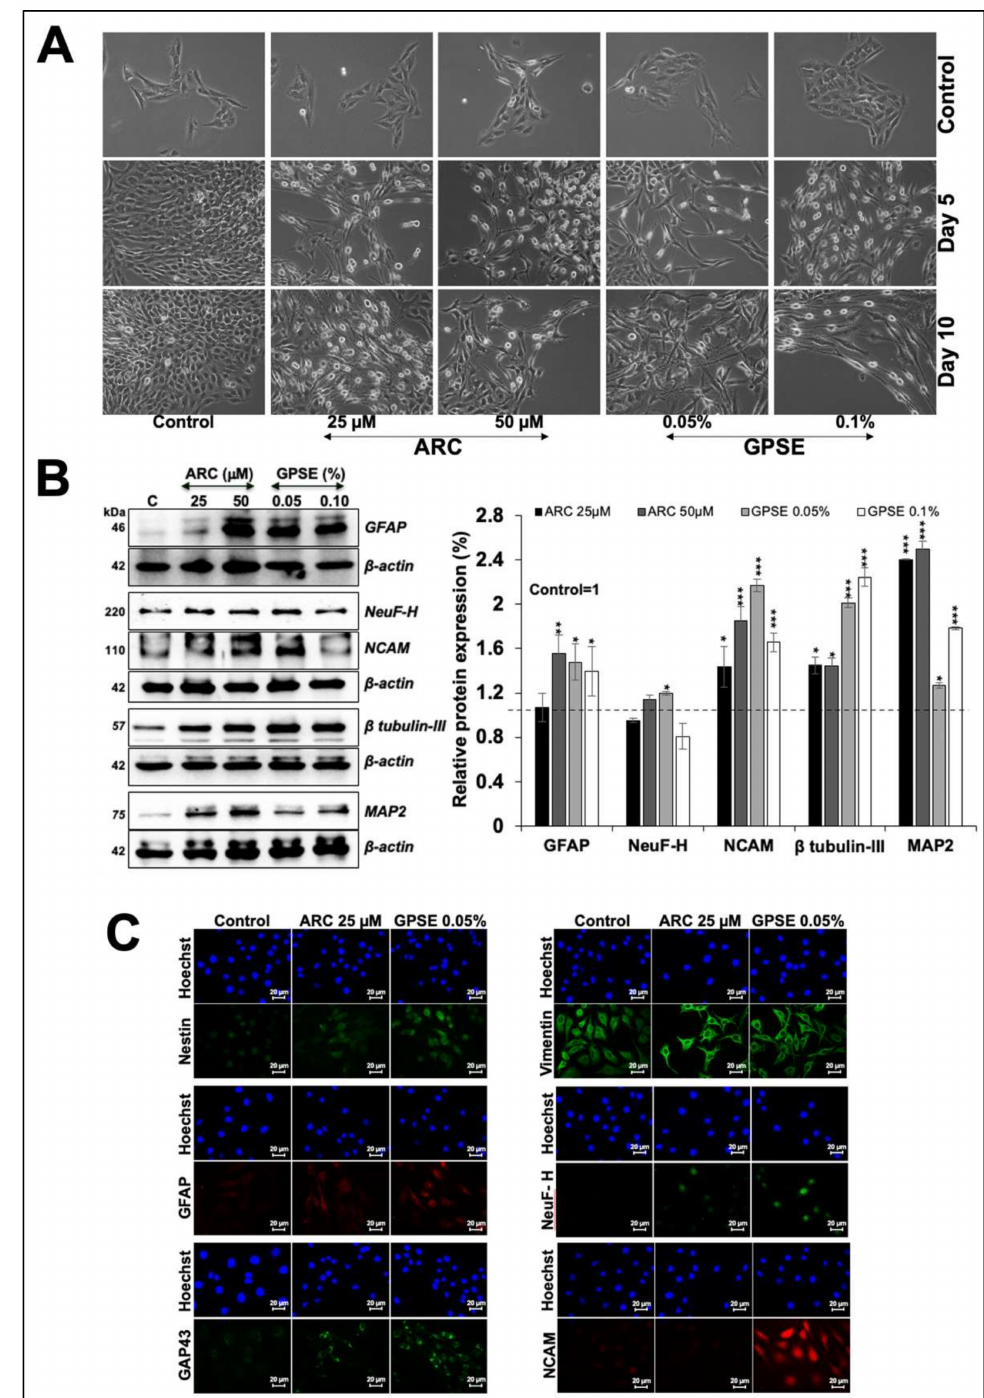
Figure 5. Low dose of GPSE caused astrocytic differentiation: C6 cells treated with ARC or GPSE showed astrocytic morphology ( A ). Western blotting of control and treated cells showed increase in proteins involved in differentiation. Quantitation of the proteins from three independent exper- iments is shown on the right ( B ). Immunostaining showed upregulation of proteins involved in C6-differentiation ( C ). The quantified data represents mean ± SD obtained from three independent biological replicates; p -values were calculated using unpaired Student’s t -test. * < 0.05, ** < 0.01, and *** < 0.001 represent significant, very significant, and very very significant,